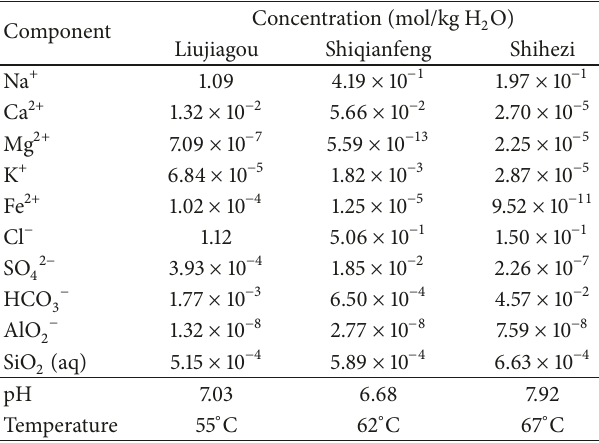
Table 3: Initial component concentrations of the formation water in the three